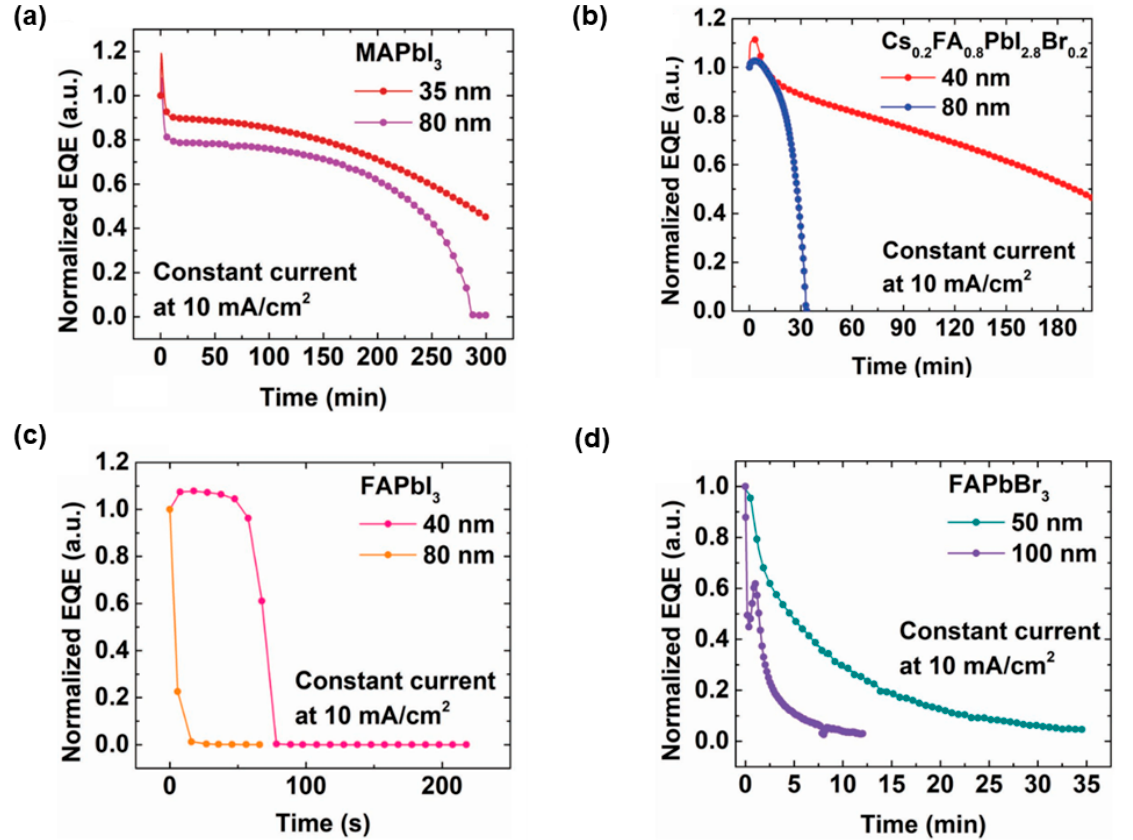
Figure 9. Operational stability of PeLEDs at 10 mA cm − 2 for ( a ) MAPbI 3 , ( b ) Cs 0.2 FA 0.8 PbI 2.8 Br 0.2 , ( c ) FAPbI 3 , and ( d ) FAPbBr 3 with various thicknesses. Reproduced from reference [229], John Wiley and Sons, 2018.